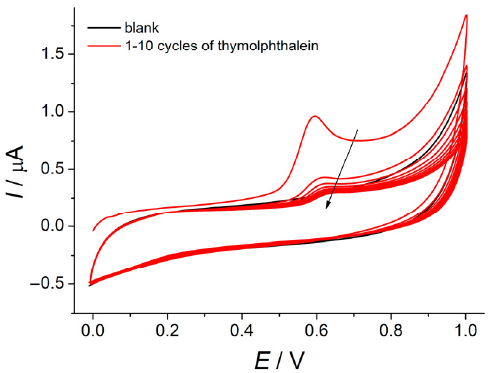
Figure 2. CVs of 10 µM thymolphthalein at the MWNTs/GCE in phosphate buffer pH 7.0 (scans 1–10). The potential scan rate is 100 mV s –1 . The arrow shows the changes of the thymolphthalein oxidation currents with increase of the number of cycles.